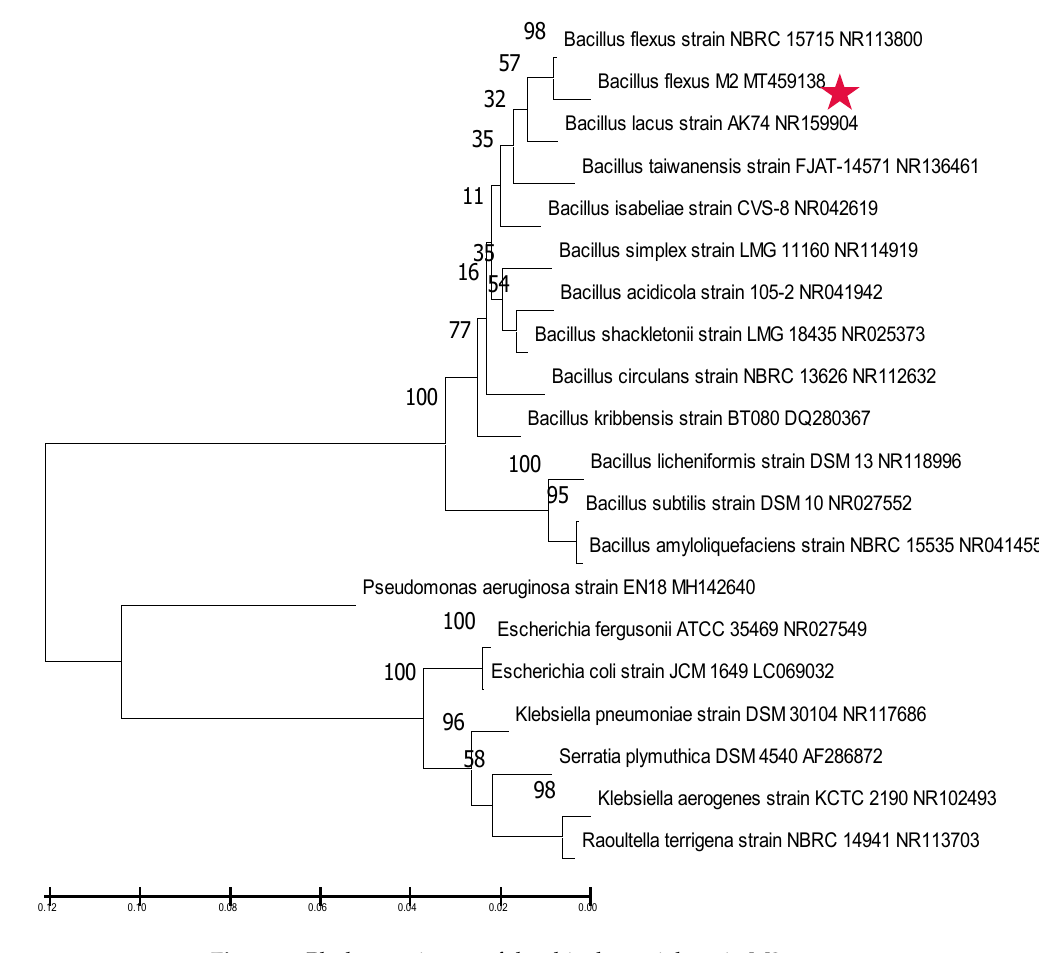
Figure 2. Phylogenetic tree of the rhizobacterial strain M2.